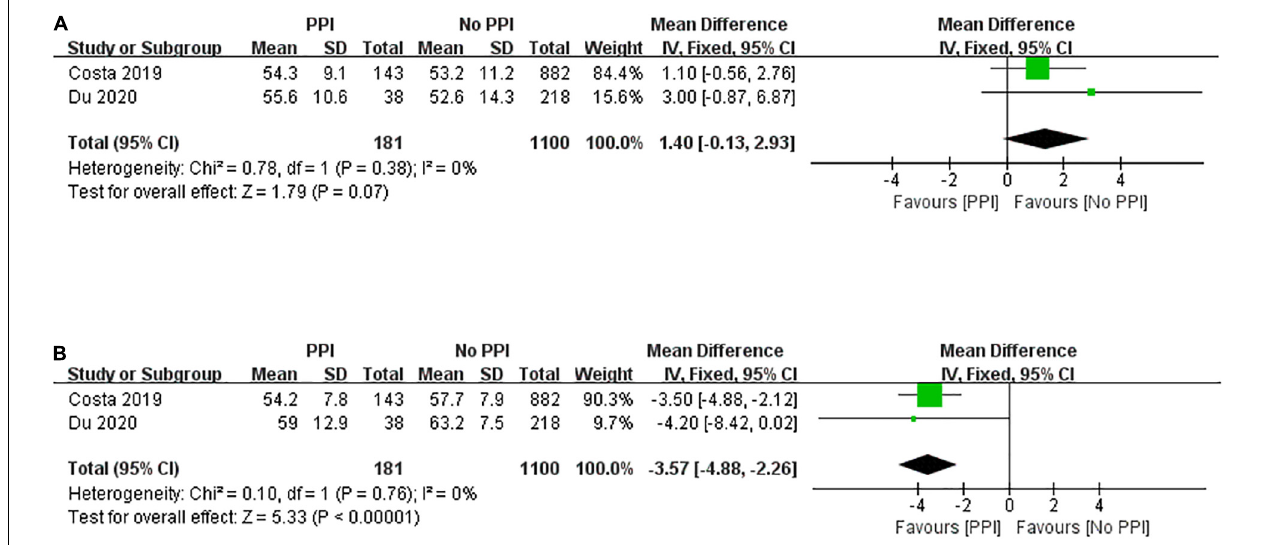
FIGURE 4 | Forest plot of left ventricular ejection fraction at baseline (A) and 1-year follow-up (B) between patients with and without post-procedural PPI after